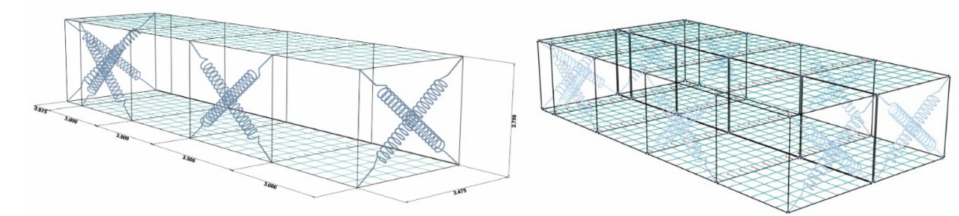
Figure 3. Modeled 3D light-frame modules.